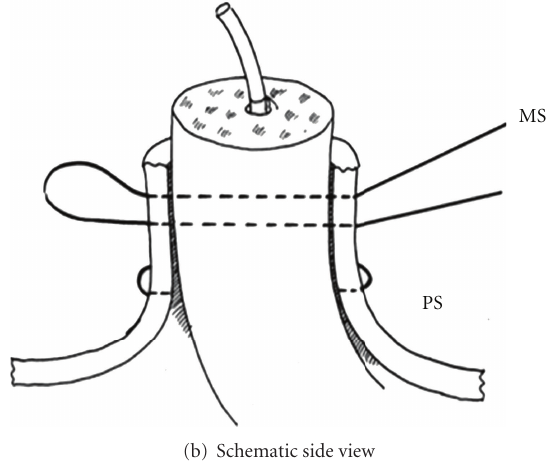
Figure 5: Situs after placement of the 2 mattress sutures and the purse-string suture (side view).